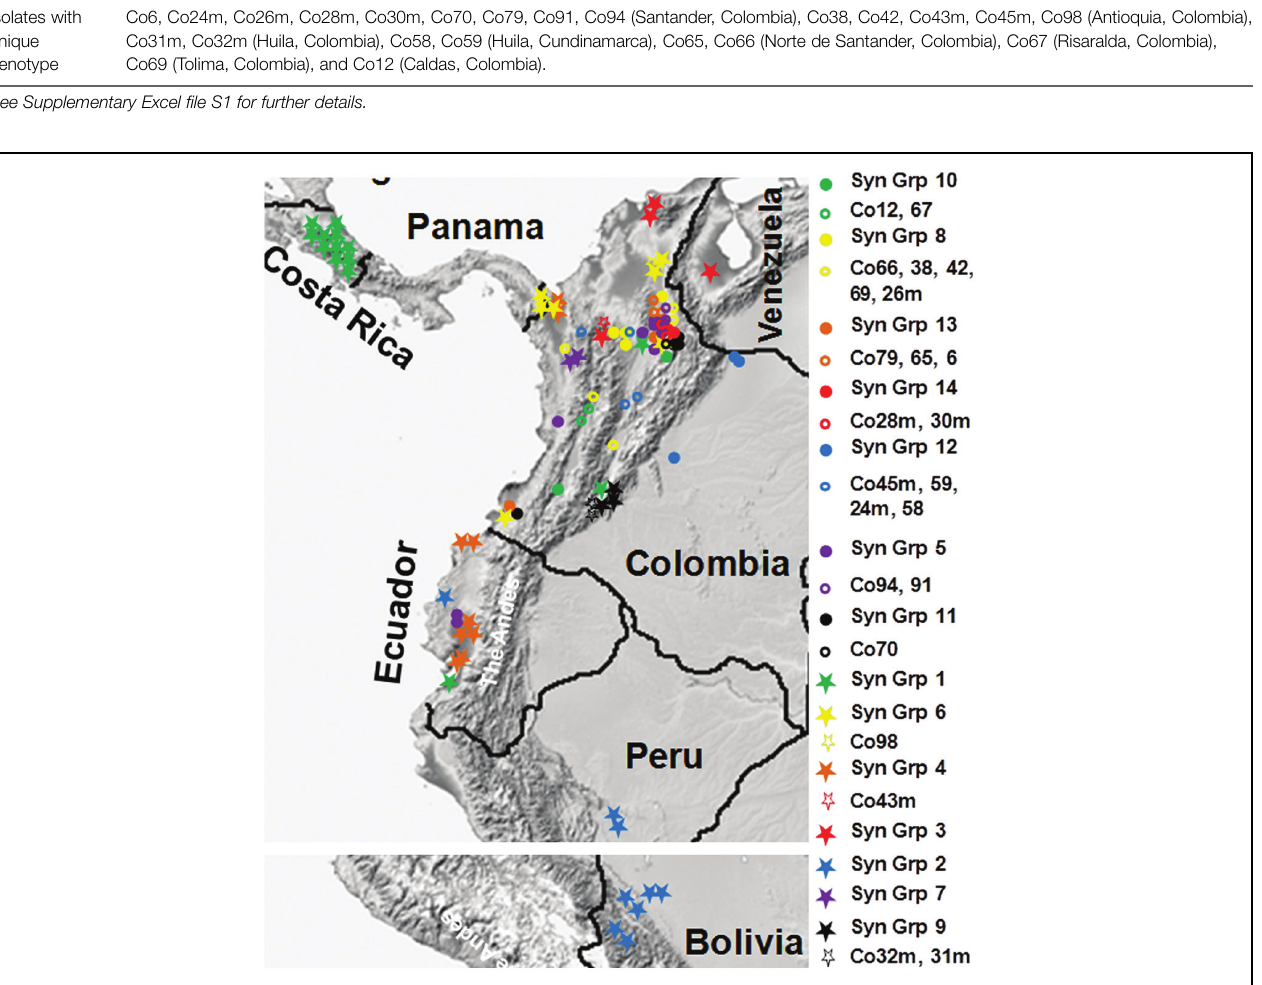
geographical locations were indicated using Google map application software. See Figure 3 for phylogenetic relationships based on the color code and Table 2 for synonymous group codes and isolates with unique